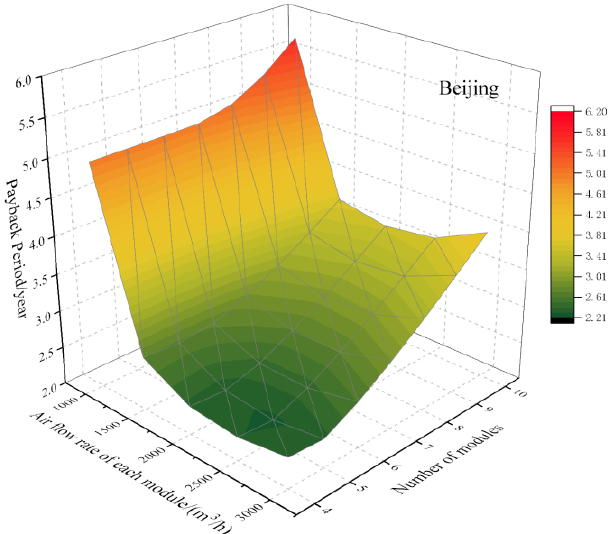
Figure 25. Payback period under different conditions. Energies 2020 , 13 , x FOR PEER REVIEW